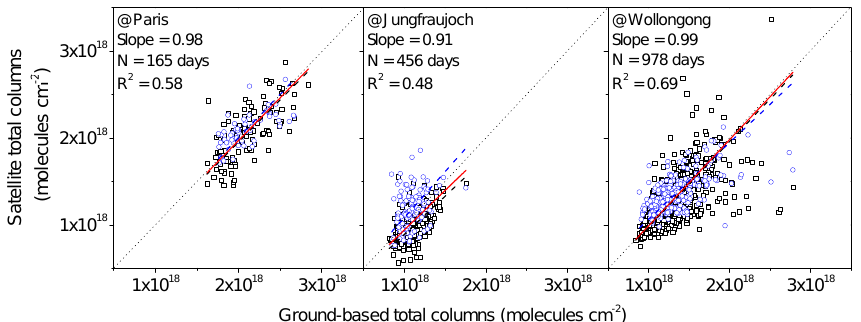
Figure 3. Correlation between satellite (IASI and MOPITT) and ground-based FTIR total columns at the three different sites, IASI data are in black squares and MOPITT data in blue circles. The dark dotted line and the blue dotted line are the robust regression fit results for IASI–MetOp and MOPITT respectively. Slope values are obtained using both data sets (red